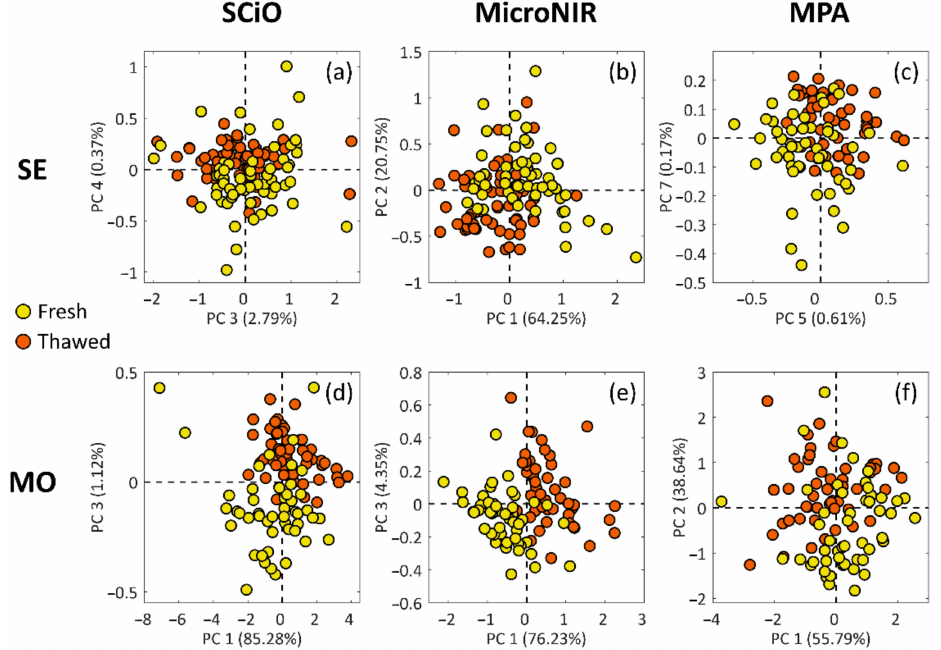
Figure 1. Most relevant PCA scores plots of cuttlefish’ (SE; ( a – c )) and musky octopus’ (MO; ( d – f )) samples. Fresh samples are depicted in yellow, while thawed samples are colored in